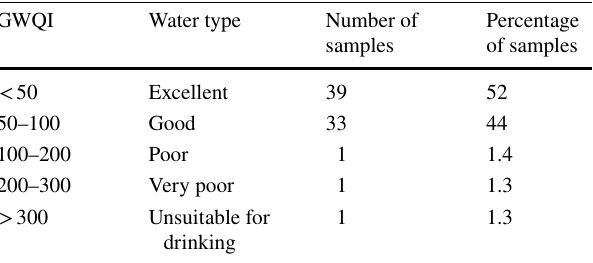
Table 5 Groundwater quality classification based on GWQI